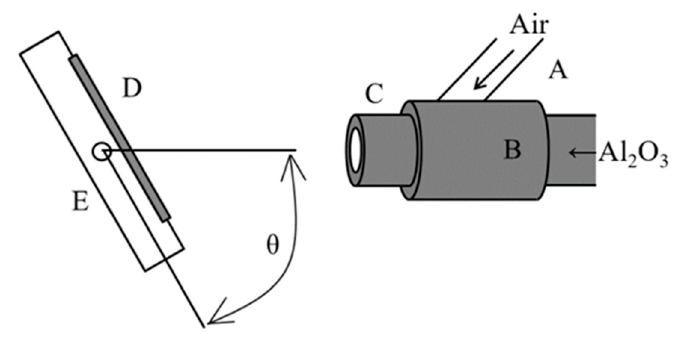
Figure 2. The equipment for particle erosion test. (A: compressed air flow; B: erosion particle (Al 2 O 3 ) supplier; C: erodent nozzle; D: specimen; E: specimen holder; θ : impact angle.)